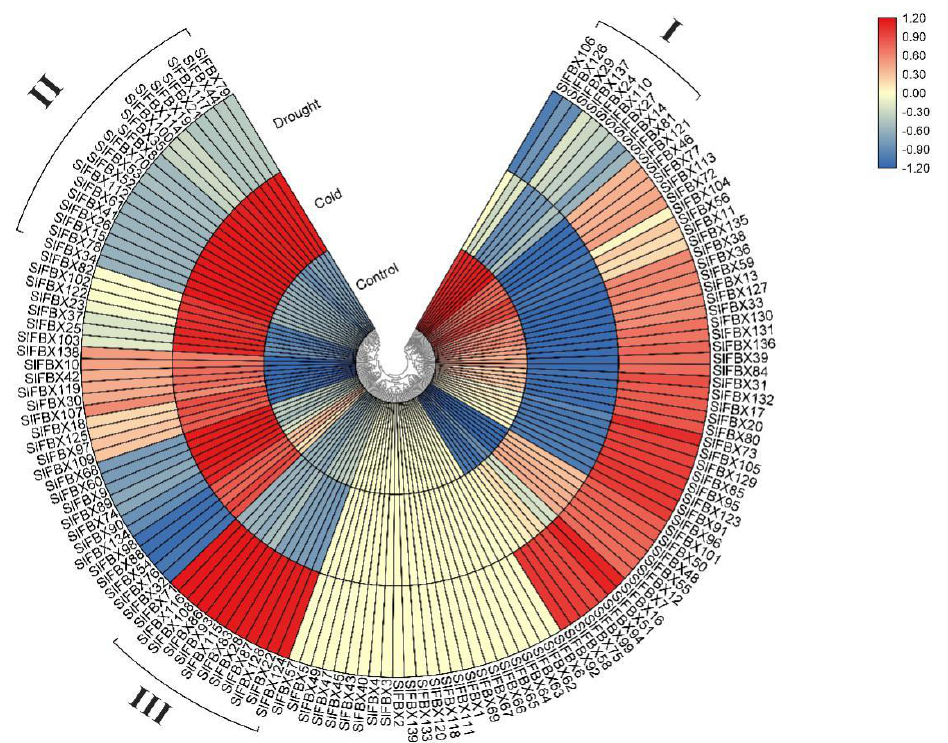
Figure 6. Transcriptional profiles of SlFBX gene family members in tomato under elevated cold stress and drought stress. blocks with colors indicate low/down expression (blue), high/up expression (red), and non-expression/no change (yellow).